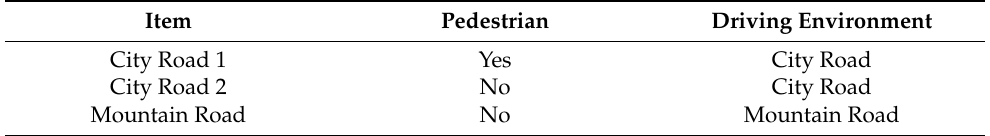
Table 1. Collision conditions by driving